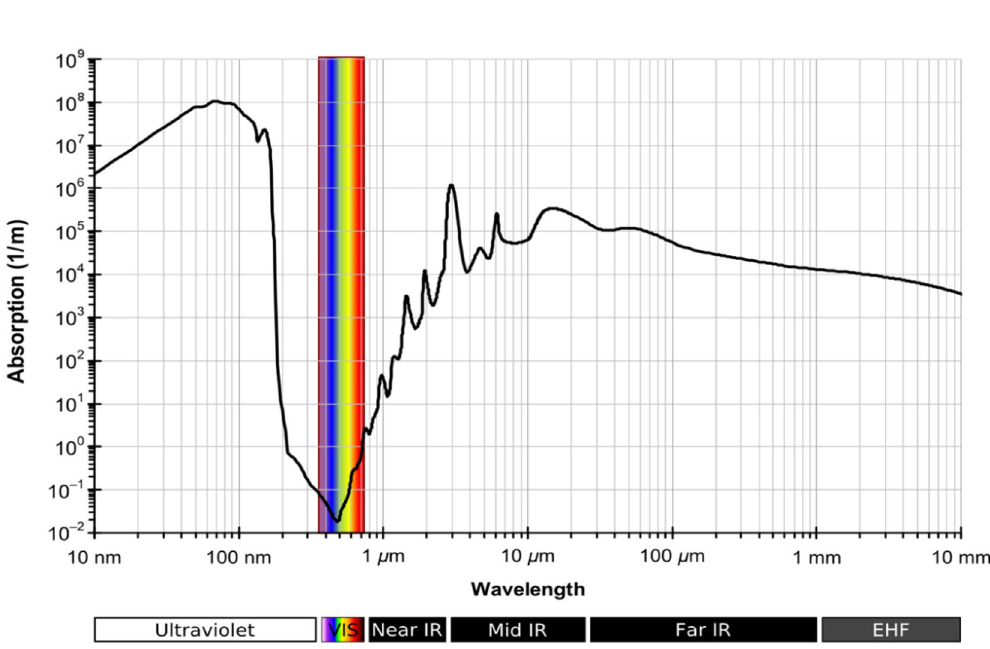
Figure 6. Water absorption spectrum as a function of incident wavelength 36